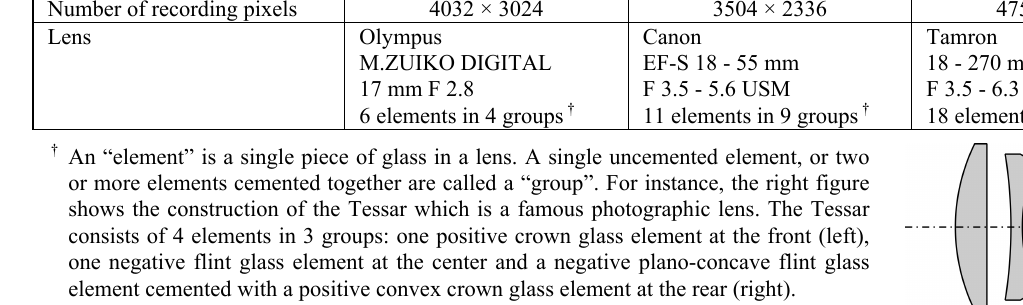
Table 3. Specifications of the investigated cameras